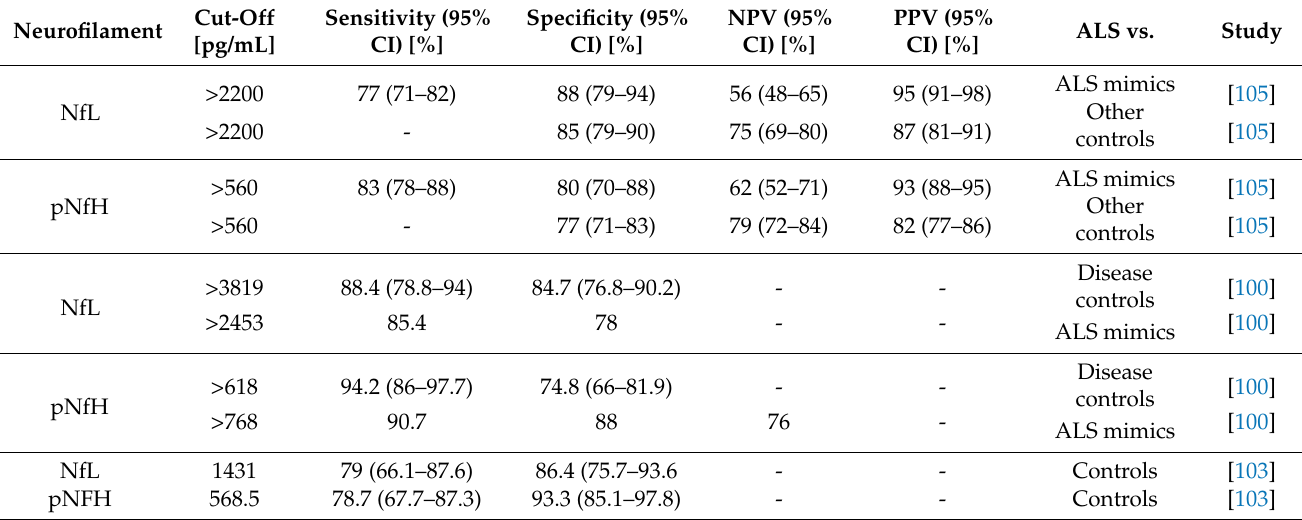
Table 3. Sensitivity and specificity of Neurofilament in CSF. Reference values for neurofilaments in the cerebrospinal fluid. Demonstrated are sensitivity, specificity and positive and negative predictive values for different neurofilament cut-off values for distinguishing ALS patients from either ALS mimics, disease controls or healthy